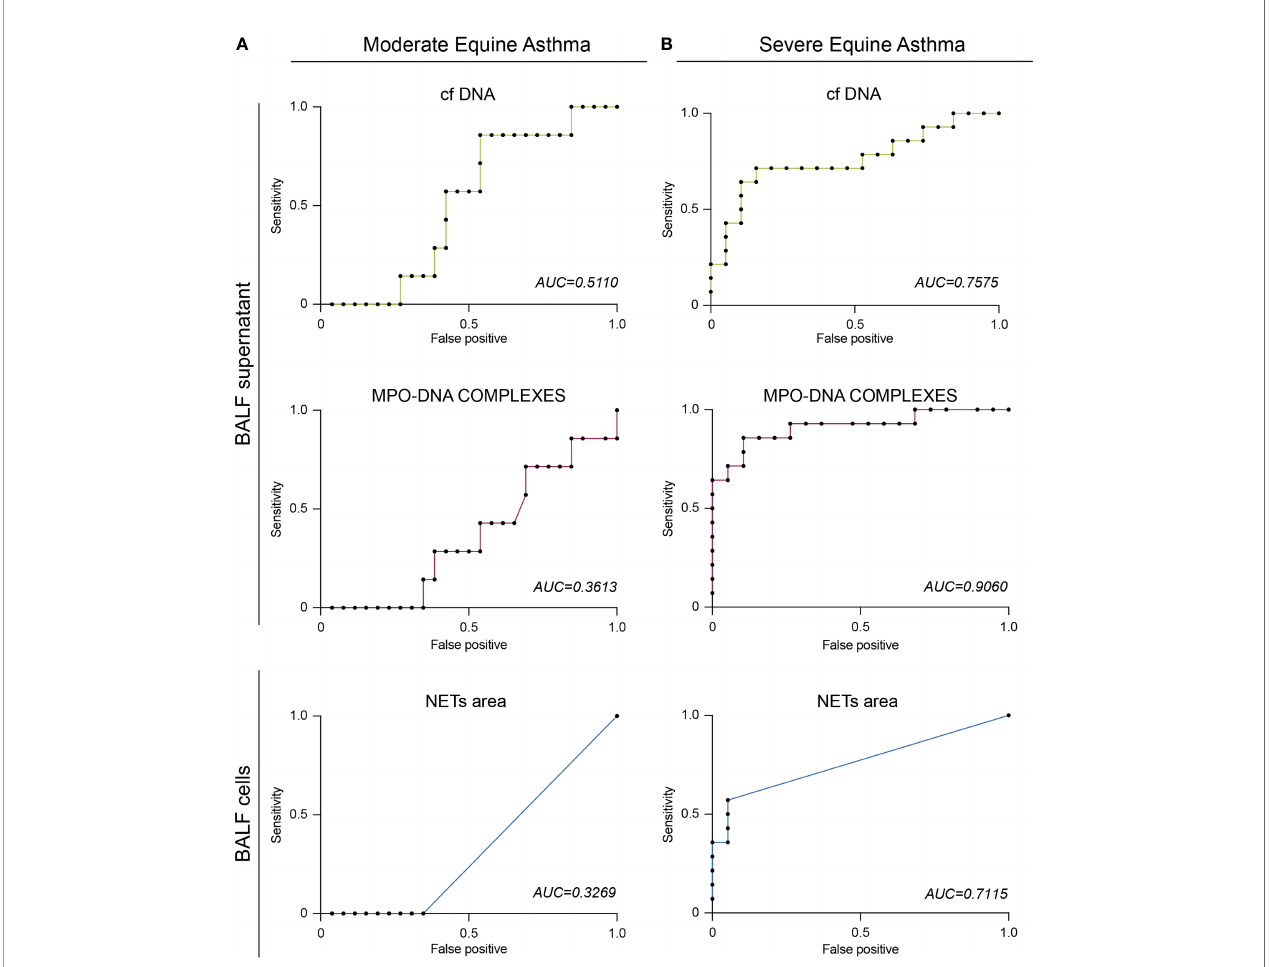
FIGURE 6 | BALF NETs can predict severe asthma in horses. (A) ROC curve of BALF cf DNA, MPO-DNA or NETs area for moderate equine asthma. (B) ROC curve of BALF cf DNA, MPO-DNA or NETs area for severe equine asthma. AUC, Area Under the